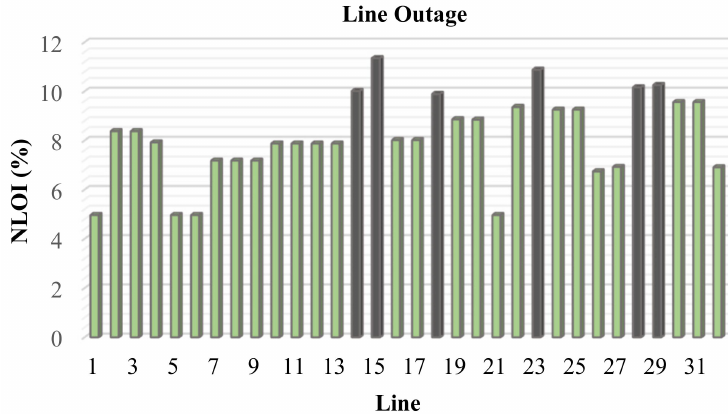
Figure 10. The NLO indexes of lines.